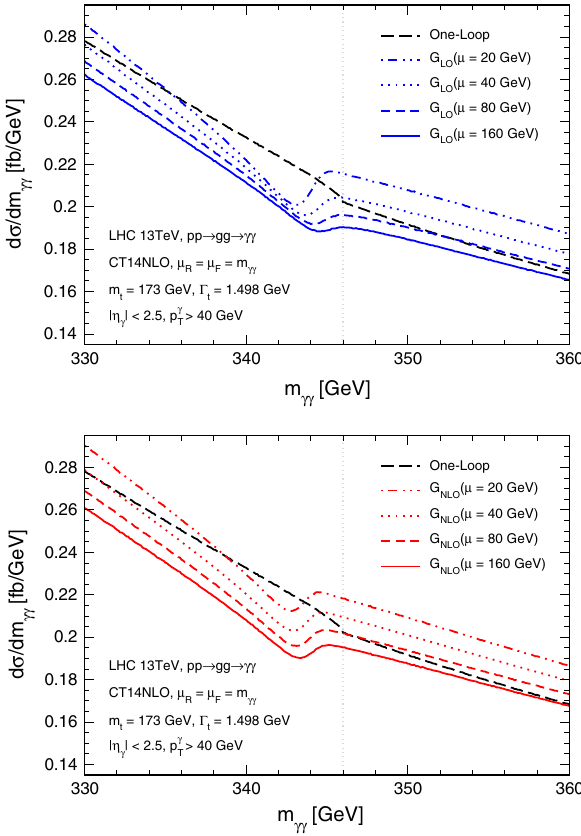
Fig. 1 gg → γγ contribution to the diphoton invariant-mass distribu- tion near the t ¯ t threshold at the LHC 13 TeV. Top panel is for the LO Green function, and bottom panel is for the NLO Green function